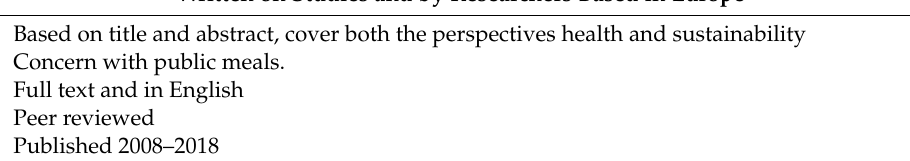
Table 2. Criteria for inclusion of